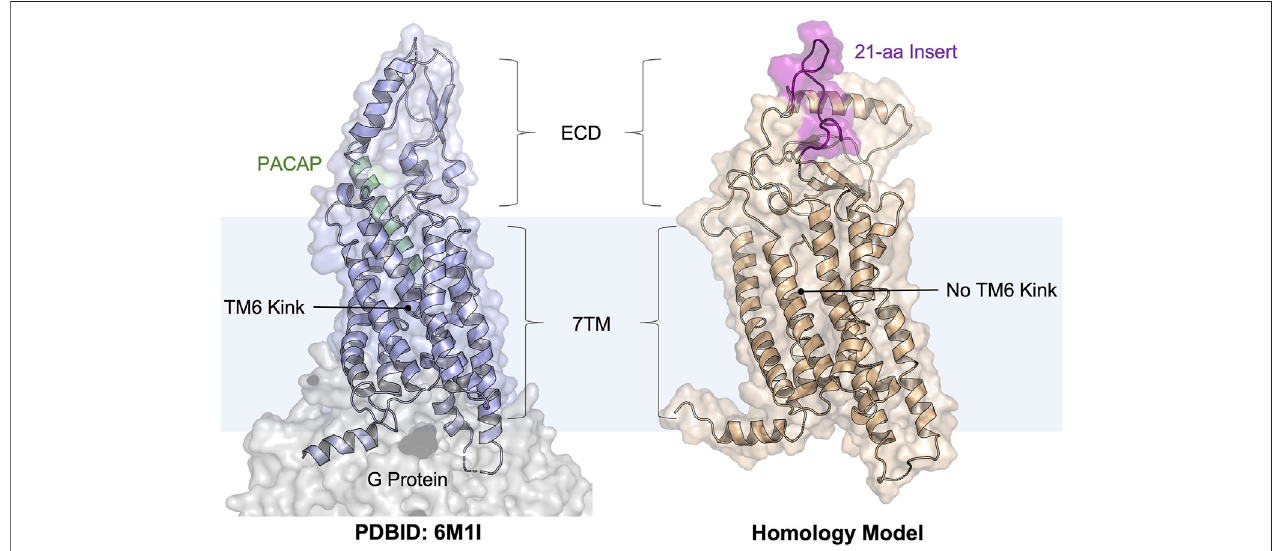
FIGURE1| Cartoon illustrations ofthe PACAP-bound PAC1R model (PDBID:6M1I,PAC1very short)and ourhomology model (template PDBID: 4L6R, PAC1null, simulation snapshot at 500 ns). The PAC1null isoform is more biomedically relevant than the very short isoform. The PACAP peptide is shown as a helix cartoon (pale green);the21-aminoacidECDinsert(seethesequencein SupplementaryFigureS1 )isshownasa fl exiblecoil(purple).Thisstudyfocusedondockingtothepeptide- binding